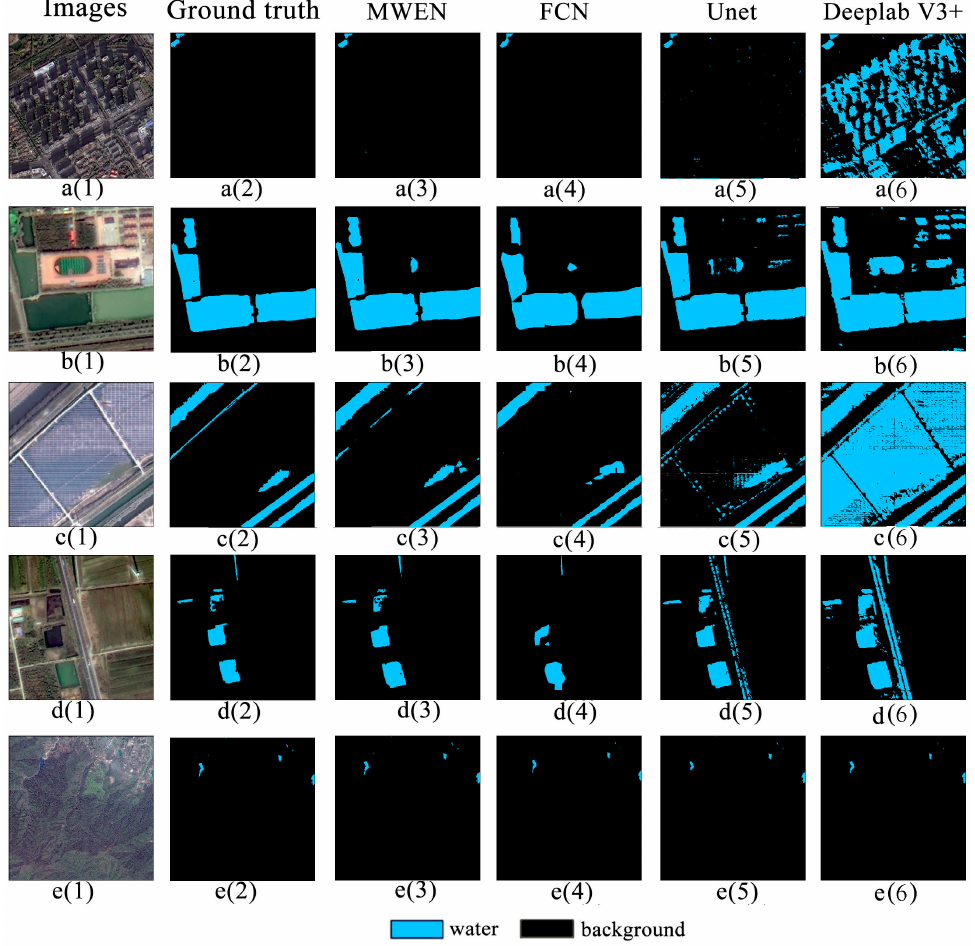
Figure 11. The results of the four methods for confusing regions. a(1) is the original image with building shadows, and a(2–6) represent the water body information extracted from a(1) by artificial interpretation, MWEN, FCN, Unet, DeepLab V3 + , respectively. Additionally, b, c, d, e give the experimental results of water body extraction from di ff erent images with playgrounds, shade net, highways and mountain shadows, respectively. Blue parts of the pictures are the water bodies and black parts of the pictures are the